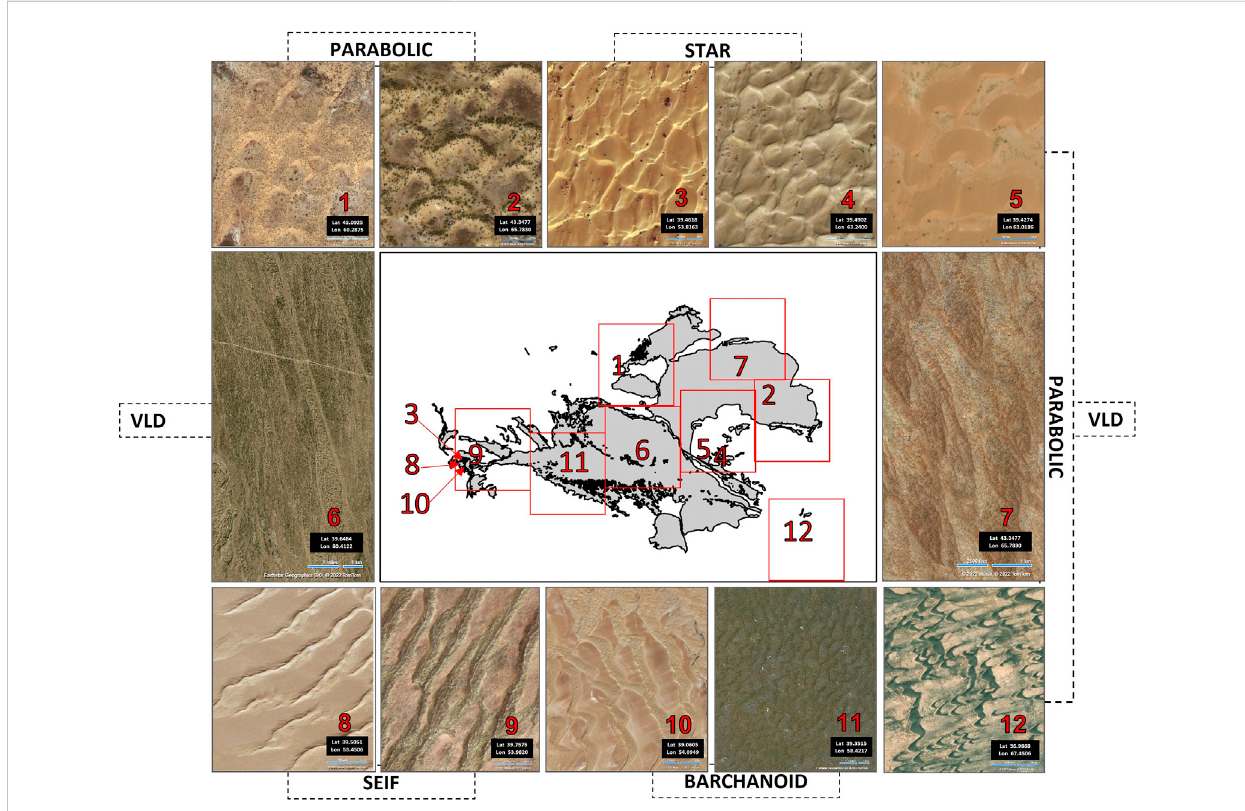
FIGURE 2 Dune types in the Karakum and Kyzylkum Central Asian deserts (KKCAD), snaped and adapted from Bing Aerial Imagery web portal (https://www. bing.com/maps/aerial). The number in the frame represents the closer position of a dune type in the region, while the frame of the window itself represents corresponding areas in Figure